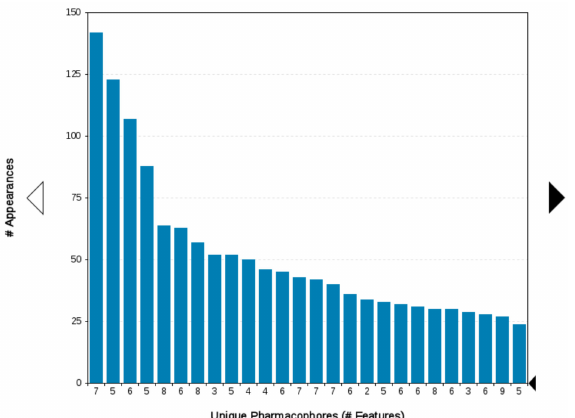
Figure 8. Plot of the most frequent unique structure-based pharmacophore models derived from the molecular dynamics simulations of the Hsp90 C-terminal domain in complex with 9i . The numbers below the bars indicate the numbers of interaction features observed during molecular dynamics simulation for the pharmacophore models.